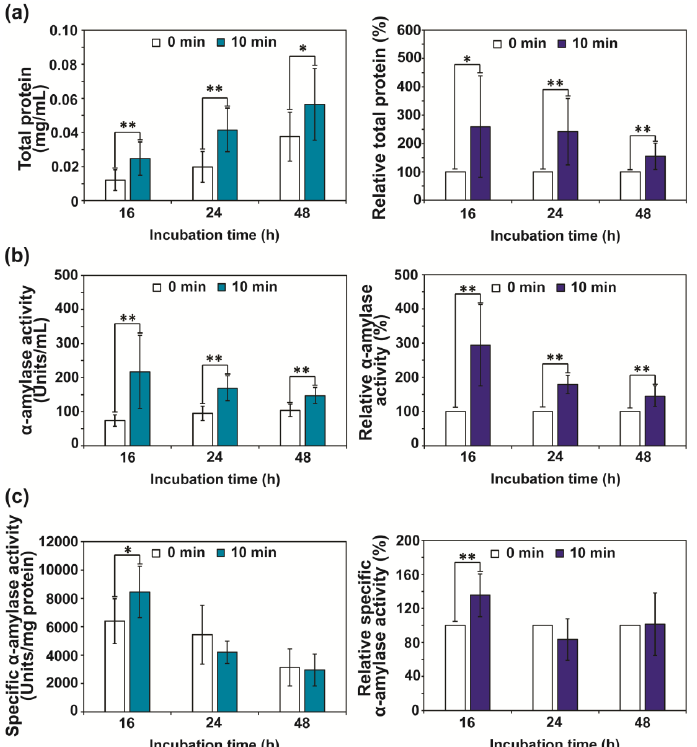
Figure 2. Level of total proteins and activity of α-amylase in media (PDB) at 16, 24, and 48 h after fungal spores in PDB were unexposed (control) and exposed to RF-EMF (2 GHz, 0.01 W) for 10 min. Each value represents the mean of nine replicate measurements. The experiment was repeated three times, each with three replicate measurements: * p < 0.05 and ** p < 0.01: ( a ) Amounts of total proteins in media; ( b ) Activity of α-amylase; ( c ) Specific activity of α-amylase.